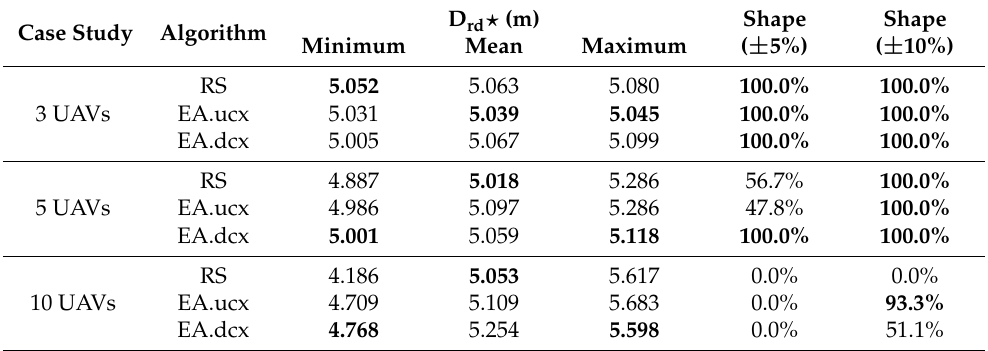
Table 4. Metrics obtained after testing the best drone parameters on 90 unseen scenarios. Best results are in